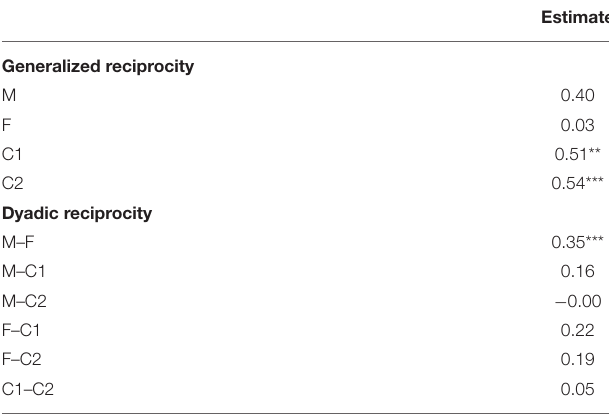
TABLE 4 | Variance and mean estimates of the normative sample’s SRM components ( p -values are based on one-sided and two-sides z -tests for the variance and the mean, respectively, * p < 0.05; ** p < 0.01; *** p < 0.001).